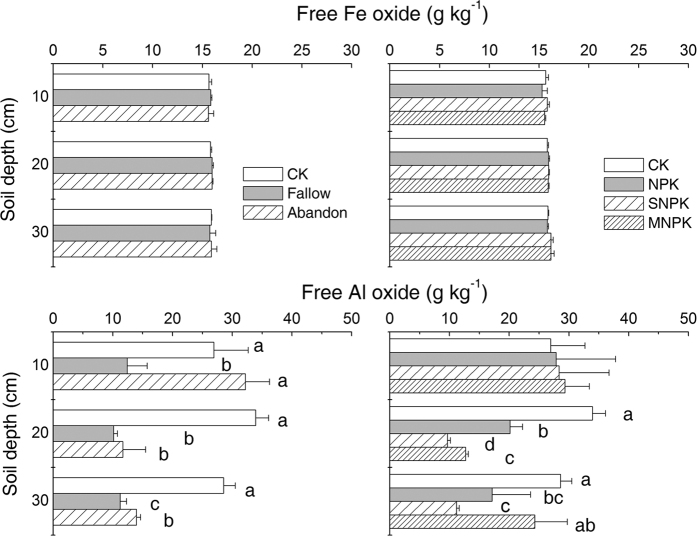
Free Fe oxide (top panels) and free Al oxide (bottom panels) concentrations in bulk soils under contrasting soil management regimes (left panel) and fertilizer treatments (right panel).Error bars denote standard deviations (n = 3). Different small letters mean significant differences between treatments, at a given soil depth, at 0.05 (n = 3); no letters means no significant difference. Two-way ANOVA tests indicate the effects of soil management regimes and soil depth and their interaction on free Fe oxide content were not significant, and the effects of fertilizer treatment and soil depth (P = 0.005) and their interaction (P = 0.337) on free Fe oxide content. They also indicate the effects of soil management regime (P = 0.000) and soil depth (P = 0.001) and their interaction (P = 0.000) on free Al oxide content, and the effects of fertilizer treatment (P = 0.000) and soil depth (P = 0.000) and their interaction (P = 0.002) on free Al oxide content.